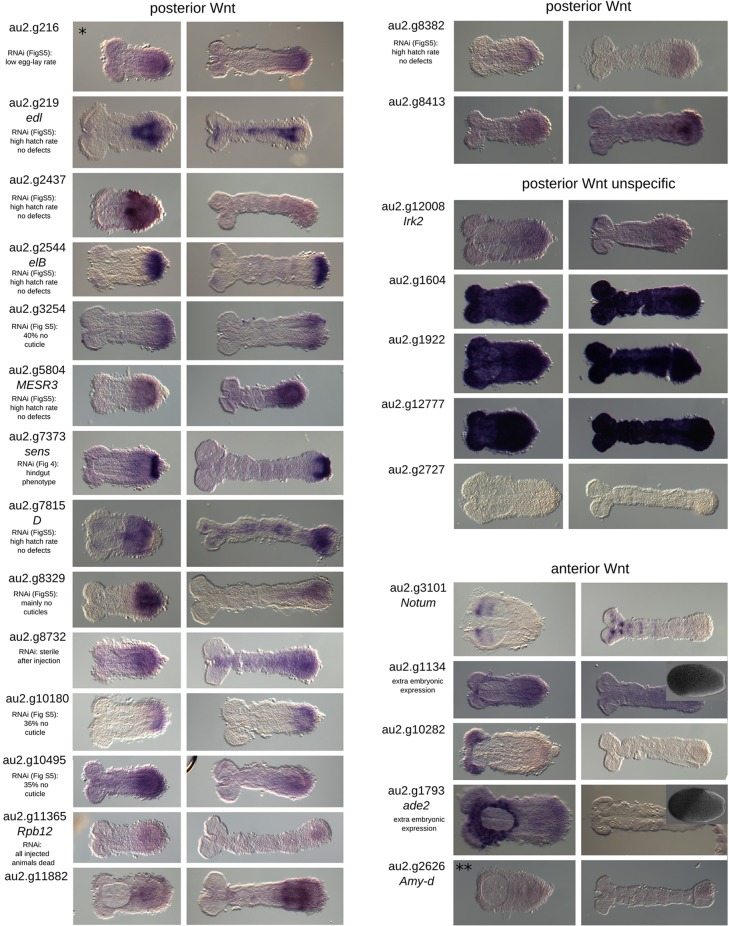
In situ hybridization of Wnt target candidates. Posterior Wnt targets: 23 candidate genes were selected for evaluation in the in situ screen. We obtained clones for 21 of them. These included seven genes with a Drosophila ortholog or homolog known to be involved in signaling and that are transcription factors. Six of these candidates showed specific posterior expression in the early germ band rudiment. In addition, 14 genes with no Drosophila homolog were added to the candidates for the in situ screen. Ten showed posterior expression. Three genes with highly similar sequences related to a retrotransposon gave ubiquitous staining and one gene did not stain at all. In summary, of the 28 candidates (seven already published, seven with Drosophila homologs and 14 unknown) that we examined, 23 (82%) are expressed at the posterior in Tribolium. Gene au2.g216 (asterisk) is an overlapping candidate from both the Wnt and Hh gene sets. Anterior Wnt targets: this gene set contains eight genes. We selected six for the in situ screen and obtained clones for five. Tc-notum and au2.g10282 are expressed exclusively in the head at this early stage. Tc-adenosine2 and au2.g1134 are expressed in the extraembryonic region at the anterior. Tc-amylase distal showed no expression. Tc-ey was known to be expressed in the head. Of the six genes (one published, three with Drosophila homologs and two unknown) that we examined, three are localized in the anterior germ band (50%) and two in the anterior extraembryonic region (33%). Tc-amylase distal (double asterisk) is an overlapping candidate from both the Wnt and Hh posterior gene sets. Insets show anterior expression at the blastoderm stage.